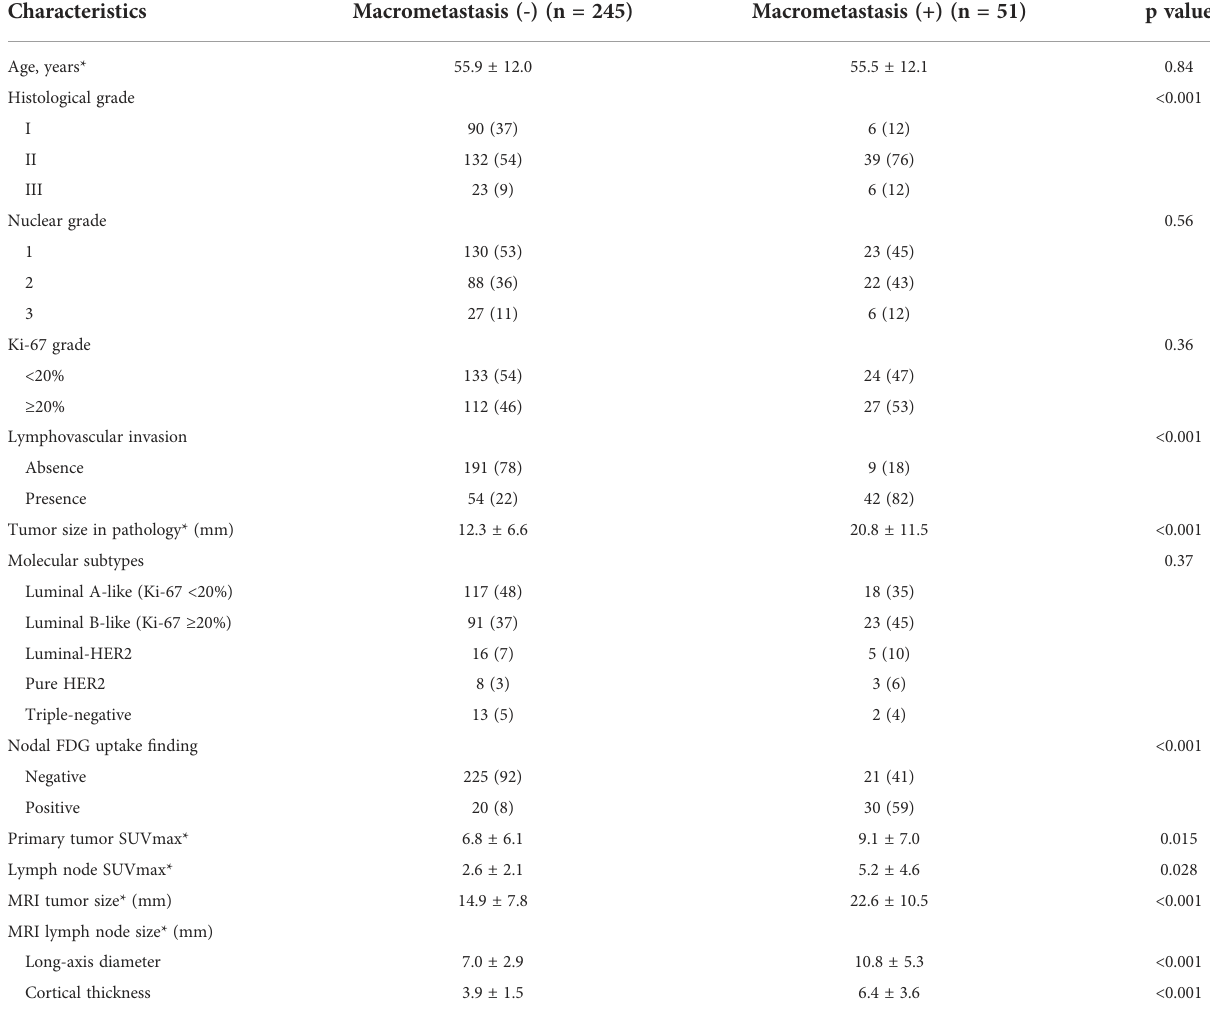
TABLE 1 Patients ’ characteristics with or without axillary lymph node macrometastasis in the derivation cohort.